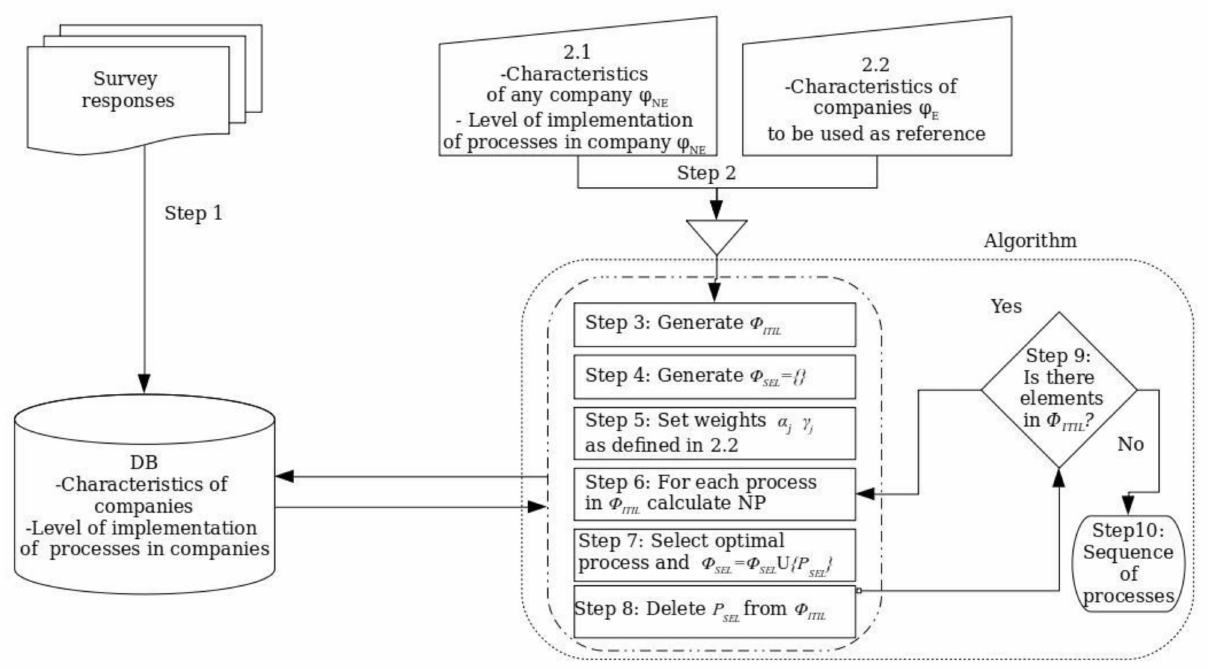
Figure 2. Steps to obtain the sequence of ITIL